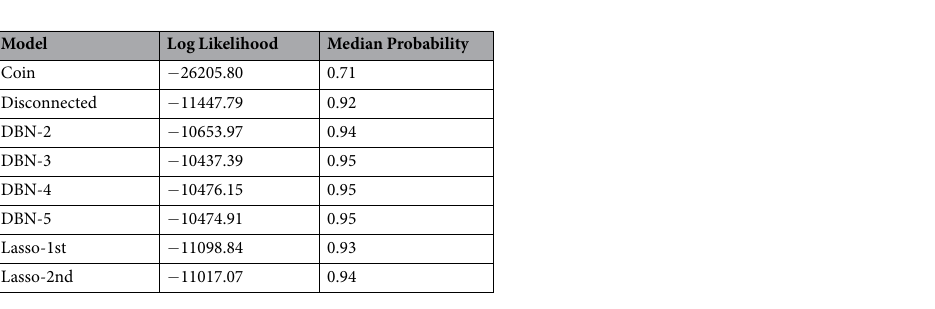
Table 2. Out-of-sample predictive accuracy for the French stream dataset. Columns represent the model name, log likelihood of correctly predicting test data, and median probability of correctly predicting a single species at a single out-of-sample time